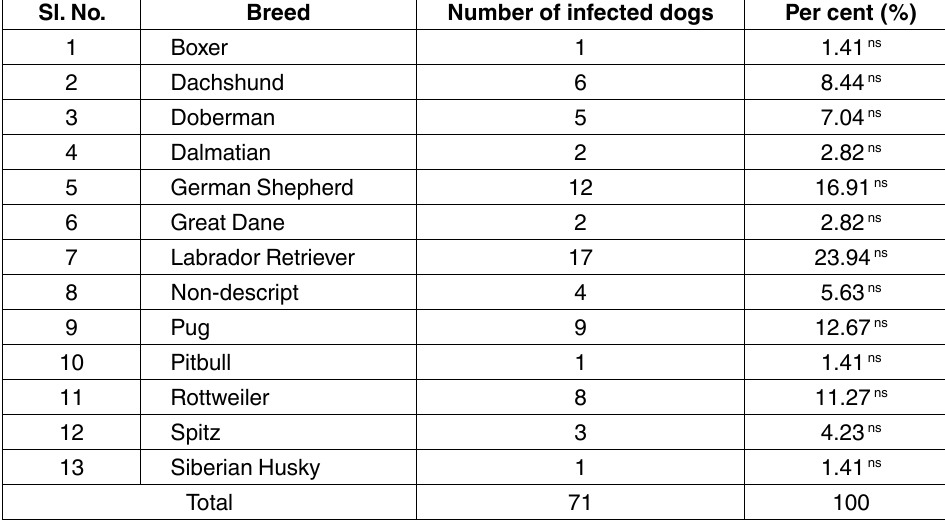
table 3. Breed wise occurrence of bacterial dermatitis in dogs sl.